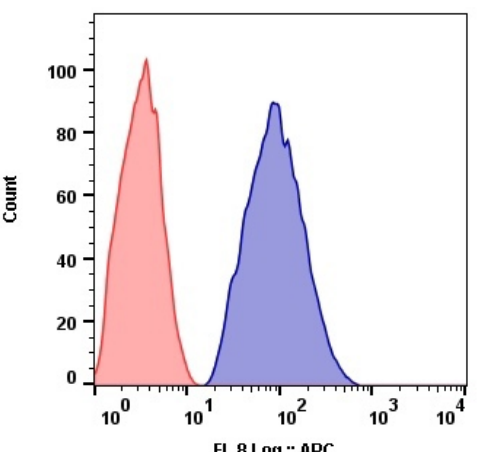
Figure 12. MCF7 cells MFI after 2 h incubation with the Nile Red-labeled capsules. Untreated cells (red).